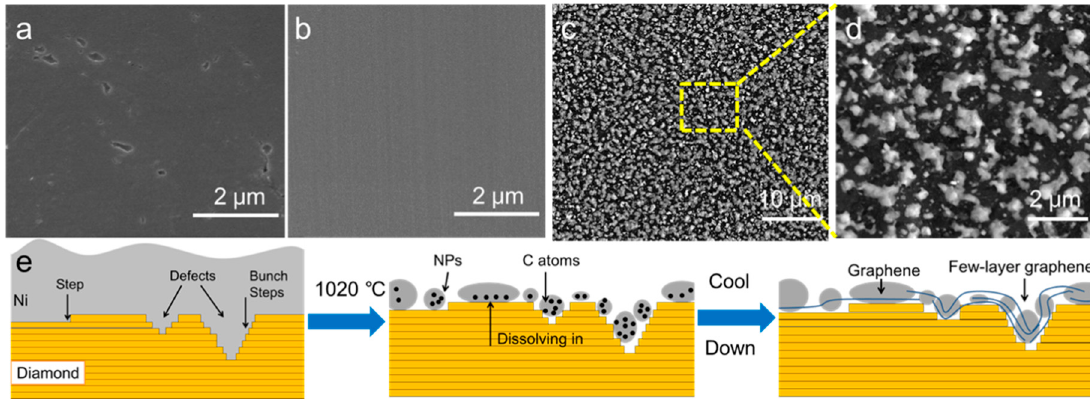
Figure 2. SEM images showing t he surface morphology of ( a ) high-pressure and high-temperature (HPHT) diamond; ( b ) Ni thin film-coated diamond; ( c , d ) Ni NPs-modified graphene–diamond hybrid. ( e ) The mechanism for single-step formation of Ni NPs-modified graphene–diamond hybrid electrodes.